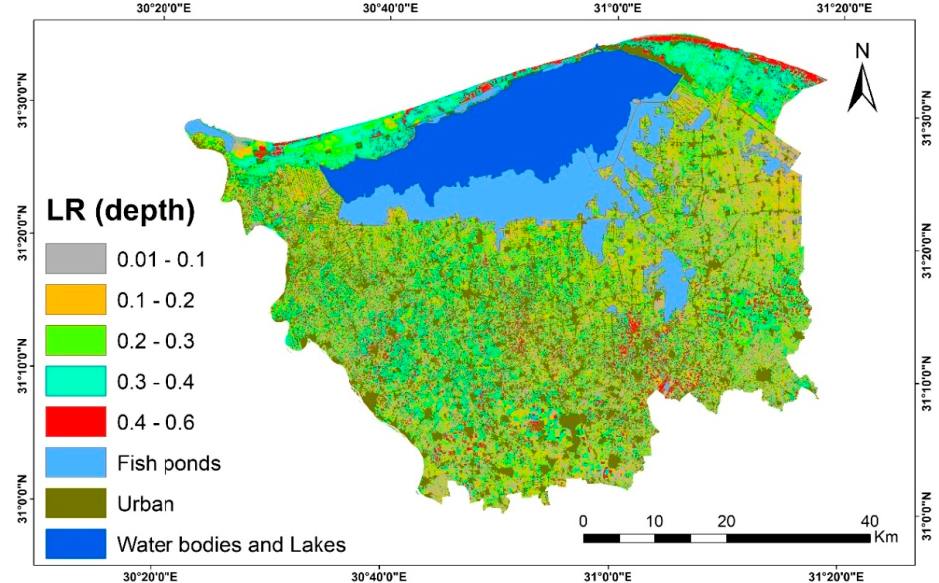
Figure 6. Different leaching requirements by satellite images for the study area.